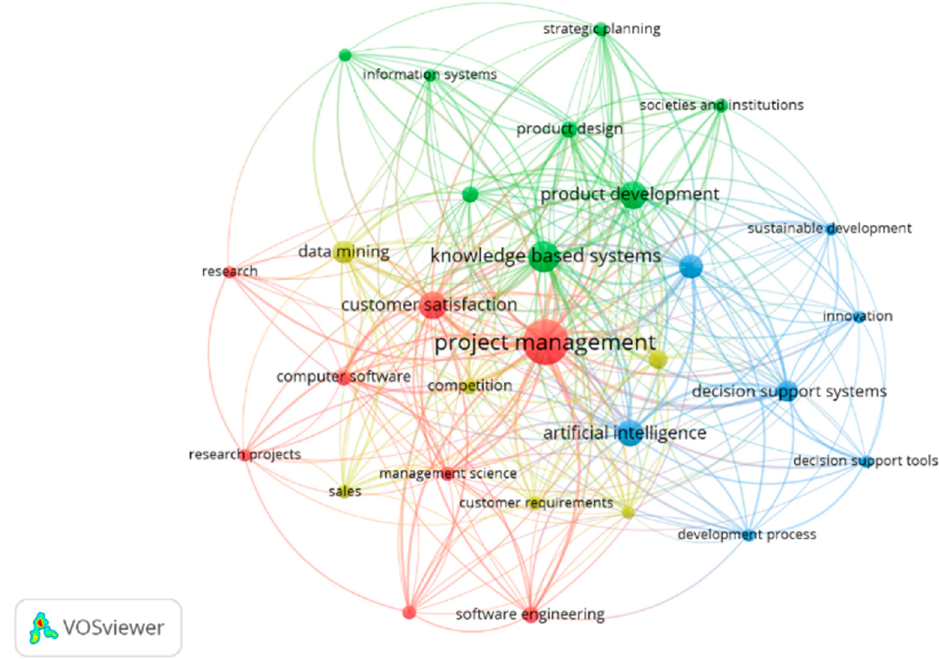
Figure 4. Clusters identified in the Stakeholders domain.